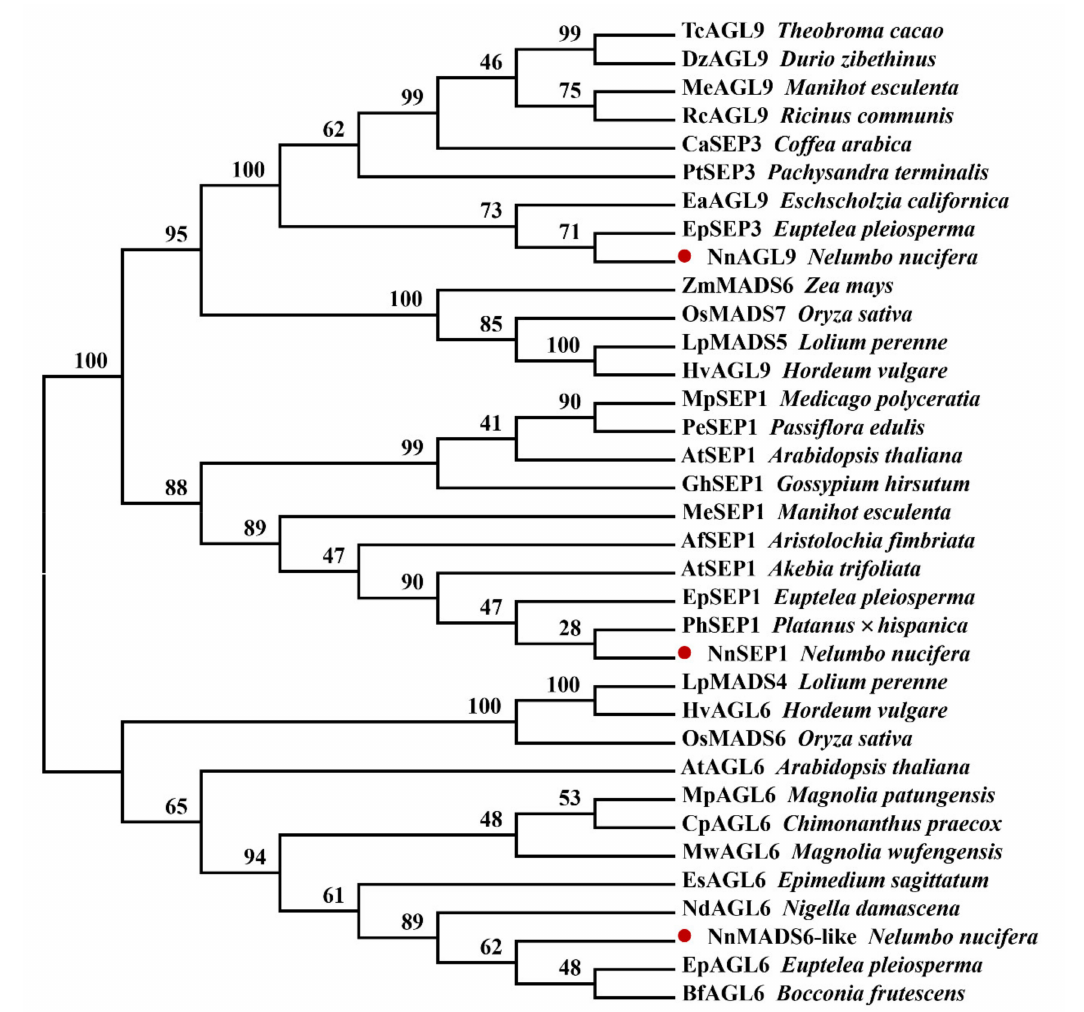
Figure 4. Phylogenetic analysis of NnSEP1, NnAGL9 and NnMADS6-like and their homologous sequences from various plant